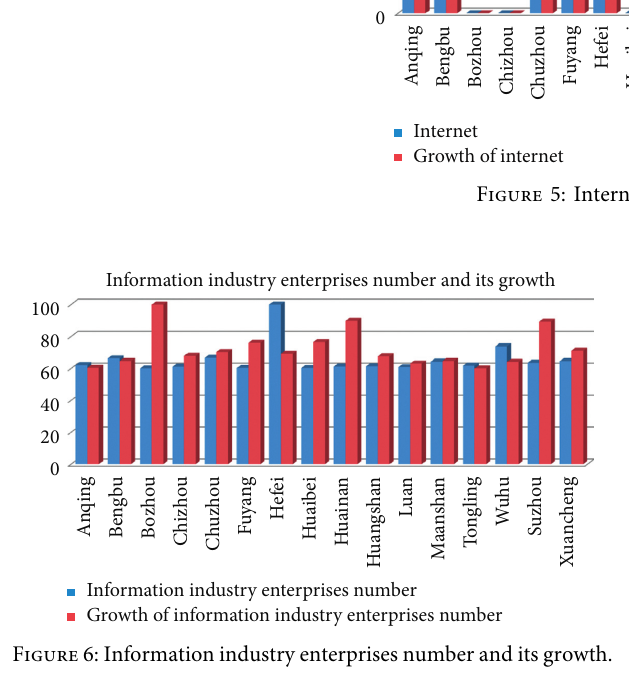
Figure 8: Technological innovation in the field of digital